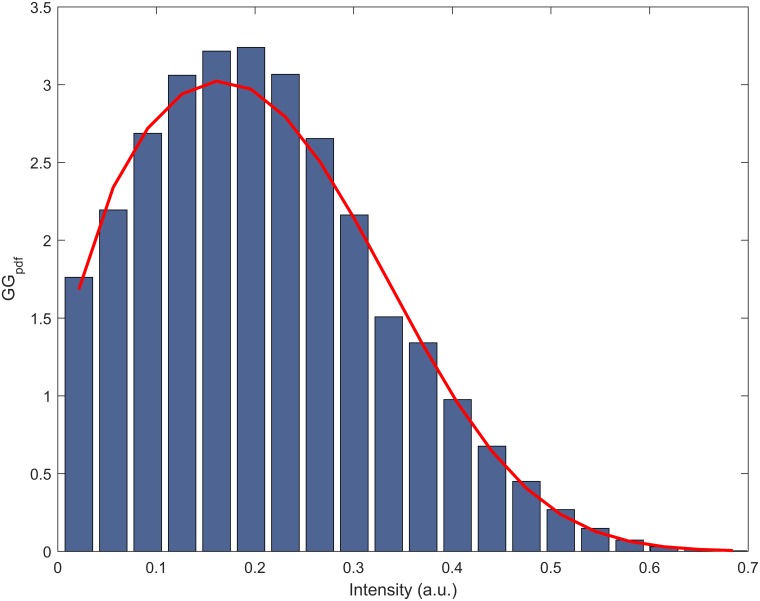
An example of a corneal intensity histogram with 20 bins and the superimposed Generalised Gamma probability density function.